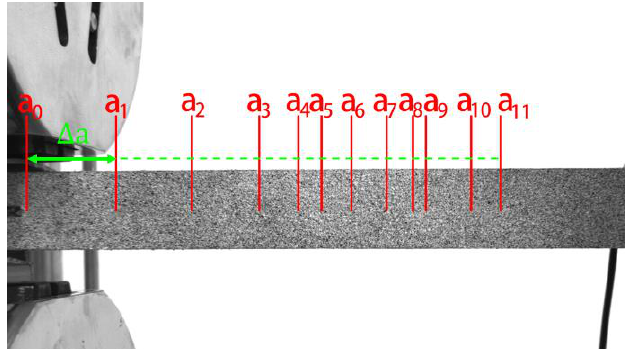
Figure 14. Distance between the 𝑎 𝑖 .